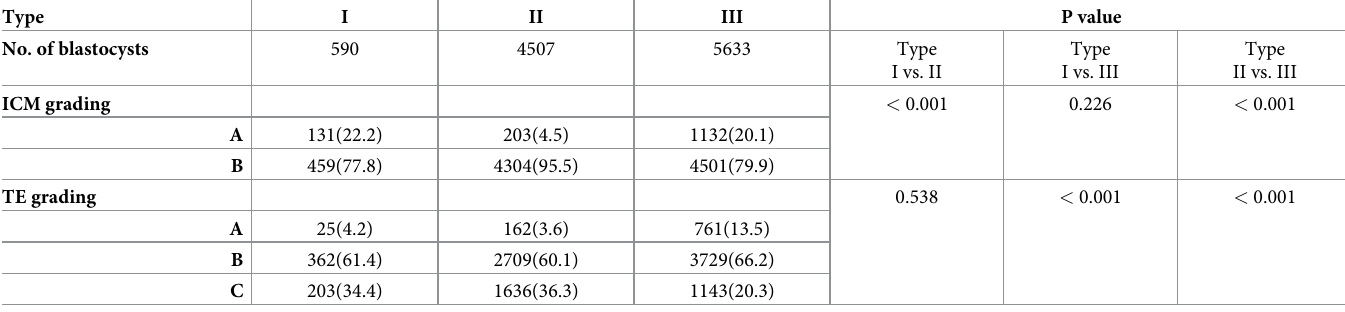
Table 2. Relationship between ICM/TE grade and hatching types in PGD/PGS blastocysts.